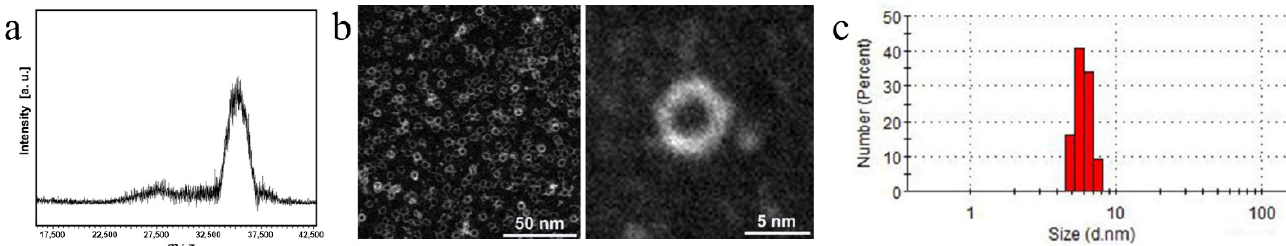
Figure 2. ( a ) MALDI-TOF-MS of Ni 36 Gd 102 in methanol [26]. ( b ) HAADF-STEM images of Gd 140 [27]. ( c ) DLS measurement result of Gd 140 in water solution [27]. Adapted with permission from Ref. [26,27]. Copyright 2020, 2017, American Chemical Society.